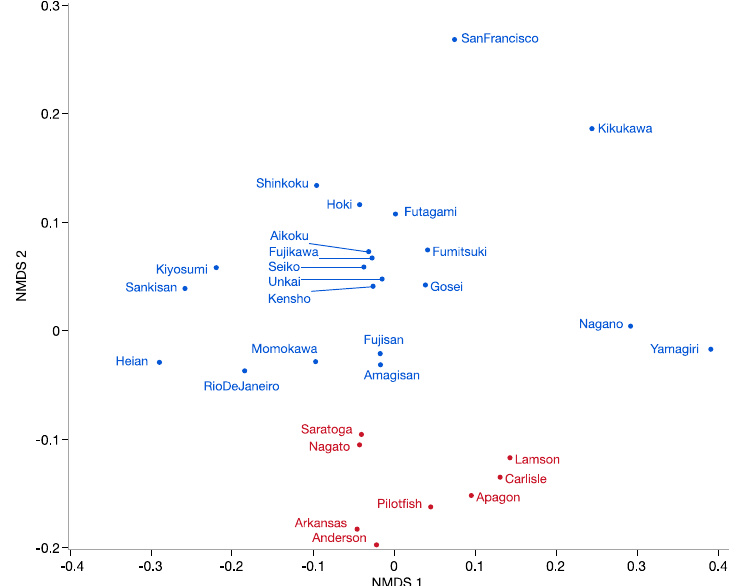
Figure 3. Non-metric multi-dimensional scaling (NMDS) plot of coral genus-level diversity among shipwrecks in Bikini Atoll (red dots) and Chuuk Lagoon (blue dots).